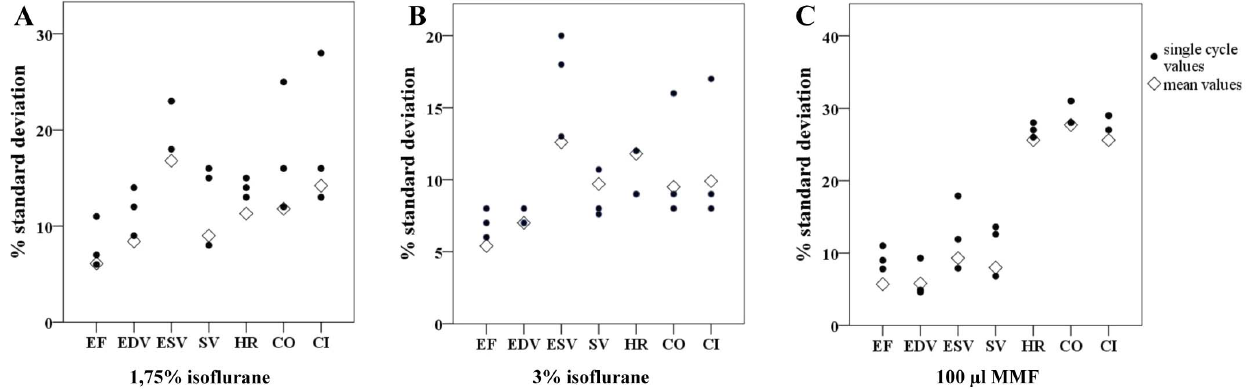
Figure 4. Calculation of an average LVEF value reduces variability of data independently from the anesthetic regimen. For evaluation of cardiac function parameters, 3 consecutive cycles were measured and averaged. Mean values showed a reduced variability compared to values obtained by single cycle measurements. A) Shows single cycle and mean values for the group anesthetized with 1.75% isoflurane, B) for the group anesthetized with 3% isoflurane and C) for the group anesthetized with 100 m l MMF. EF=LVEF, EDV=end diastolic volume, ESV=end systolic volume, SV=stroke volume, HR=heart rate, CO=cardiac output, CI=cardiac index. 100 m l MMF: n=6, 1.75% isoflurane and 3% isoflurane: n=7. doi:10.1371/journal.pone.0094615.g004 PLOS ONE |